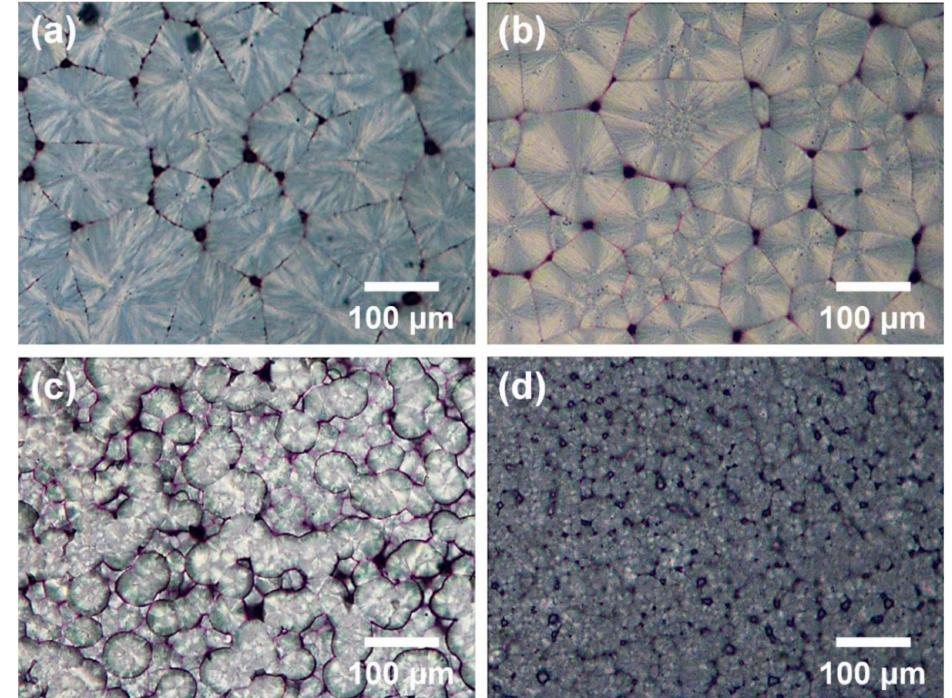
Figure 5. POM images of PKs fillers after isothermal crystallization at 210 o C: ( a ) PK/O 2 -G, ( b ) pristine PK, ( c ) PK/G, ( d ) PK/N 2